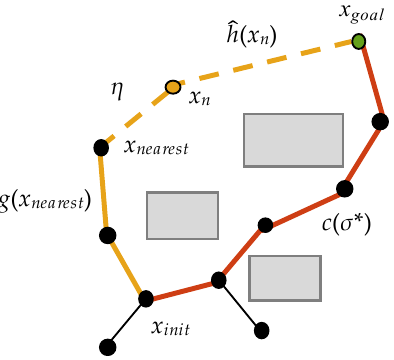
Figure 6. Tree construction. (g( x n ) = g( x nearest ) + η . )